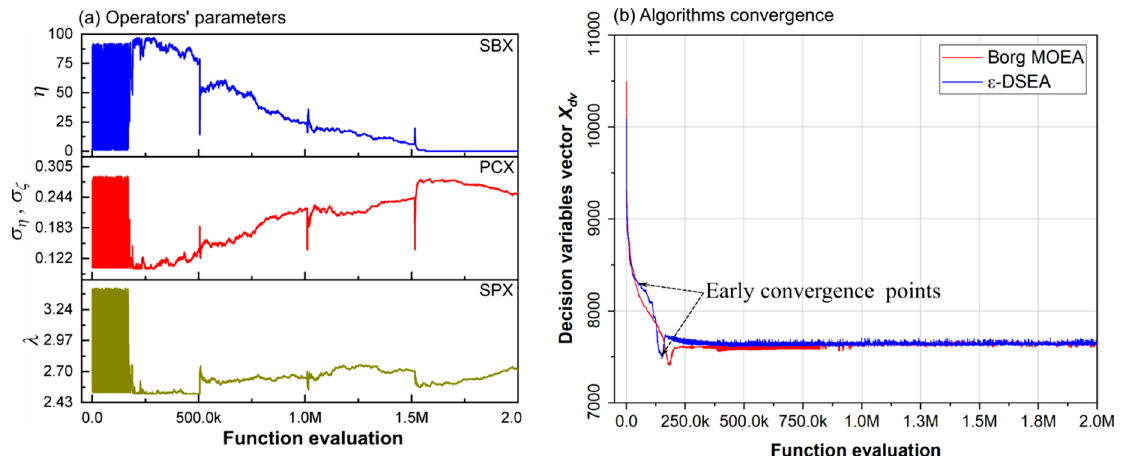
Figure 6. ( a ) Parameters self-adaptation of the most effective operators for the best solution achieved, and ( b ) algorithm convergence to generate dominance solutions during the evaluation process.